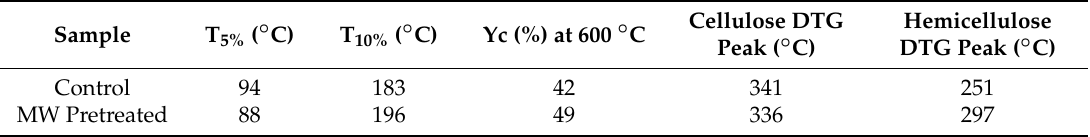
Figure 2. Thermogravimetric analysis (TGA) ( a ) and Difference Thermo Gravimetry (DTG) ( b ) of algae before and after MW pretreatment. Table 1. Thermogravimetric Analysis (TGA) and Difference Thermo Gravimetry (DTG) results of Enteromorpha before and after microwave (MW)